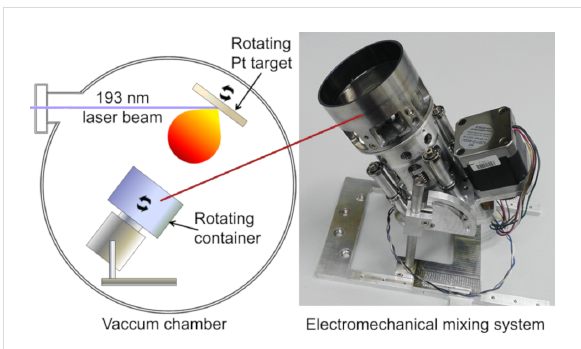
Figure 8: A schematic diagram of the PLD experimental setup (on the left) and a photo of the developed carbon support mixing system (on the